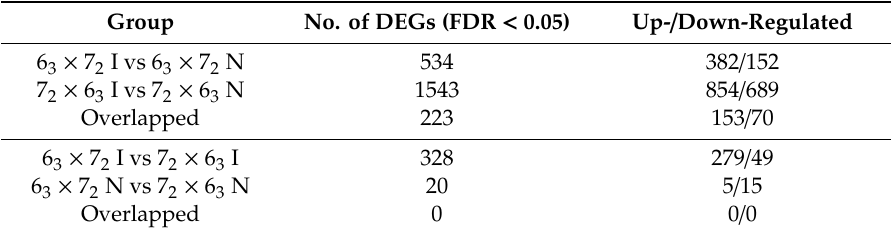
Table 6. Di ff erentially expressed genes (DEGs) of four comparison groups. Group